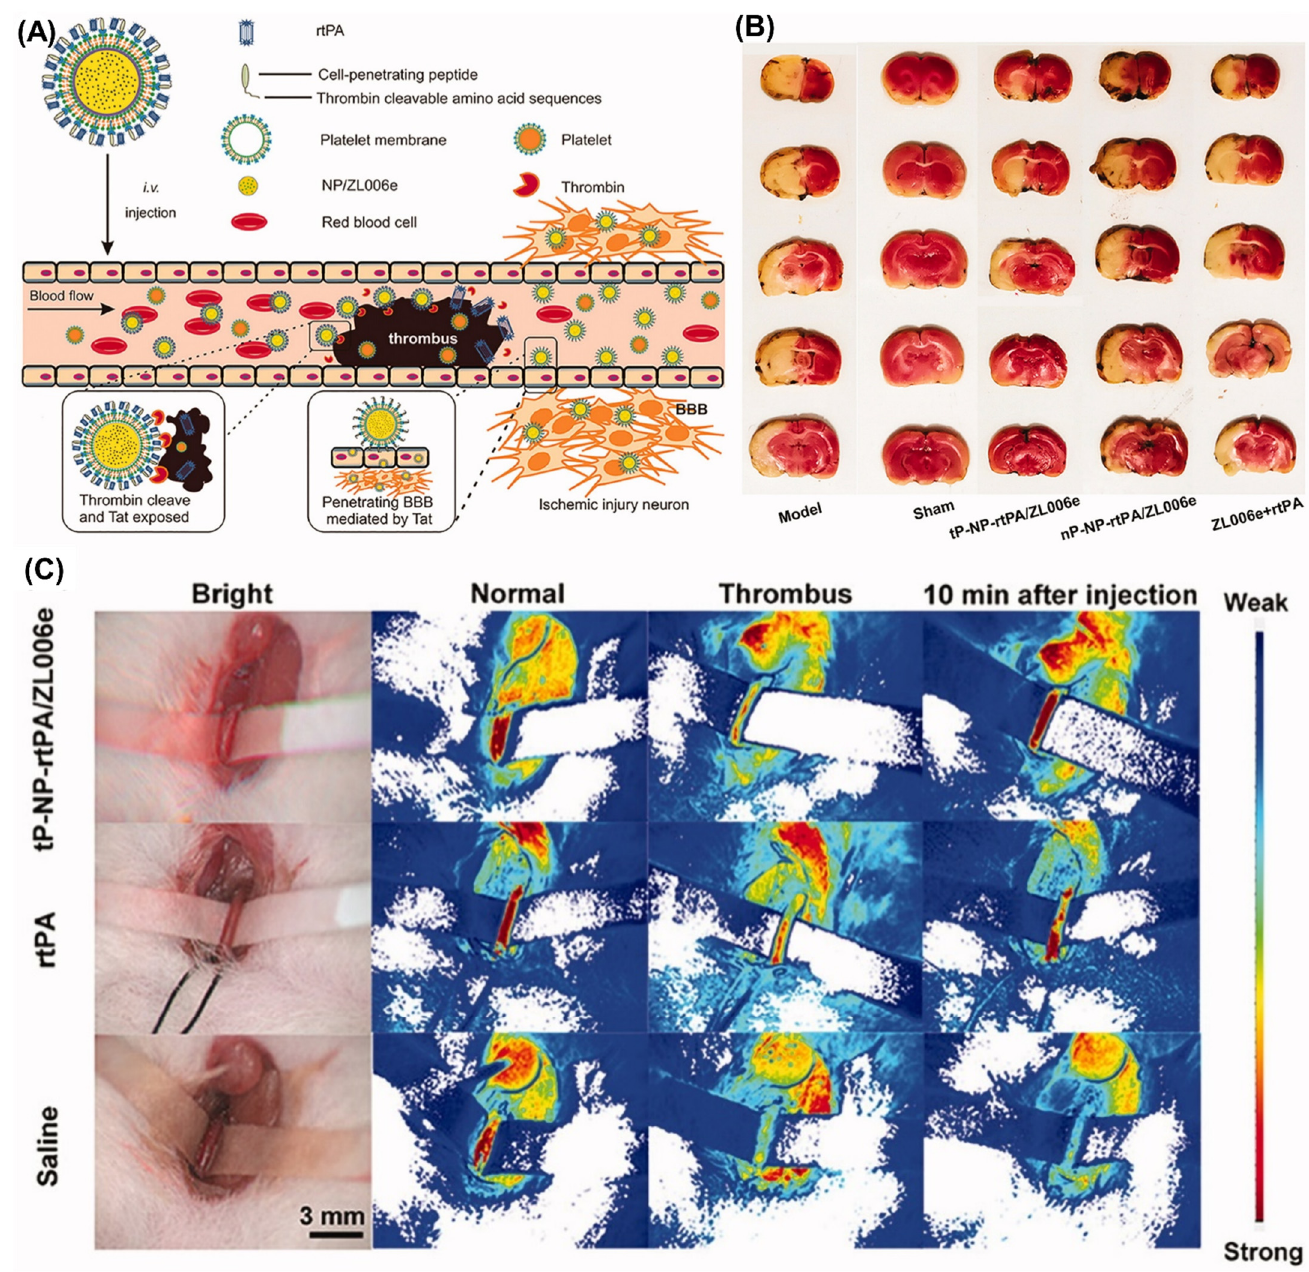
Figure 5. Targeted theranostic delivery of the rtPA and ZL006e loaded nanoplatelet and in vivo activity for the treatment of ischemic stroke. ( A ) Graphical representation of the targeted nanoplatelets and their release at targeted site. ( B ) Represent neuroprotective activity in the different group (nonischemic area is represented by red and infarct is represented by white). ( C ) Represented the targeted thrombolytic activity and blood stream recovery in the in vivo rat model whose carotid artery was damaged by FeCl 3 . Reproduced with permission from ref [130]. (American Chemical Society ® 2019).